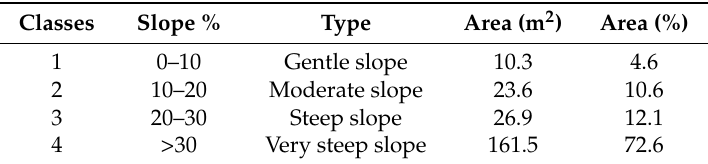
Figure 16. Slope analysis of pilaDTM to evaluate the more eroded areas. Table 2. Table of slope classes used to classify the morphology of the pila upper face and to detect the eroded